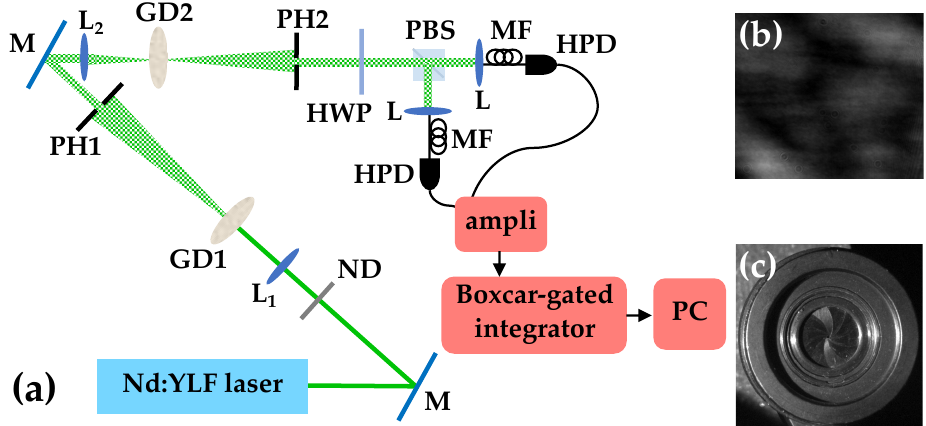
Figure 3. ( a ) Sketch of the experimental setup. M: mirror; ND: neutral density filter; L 1 : 200-mm- focal length lens; L 2 : 100-mm-focal length lens; GD1 and GD2: rotating ground-glass disks; PH1: first pin-hole; PH2: 150- µ m-diameter pin-hole; HWP: half-wave plate; PBS: polarizing cube beam splitter; L: achromatic doublet; MF: multi-mode optical fiber; HPD: hybrid photodetector. ( b ) Typical single-shot image of the speckle field in correspondence of the position of PH1. ( c ) Picture of the first pin-hole